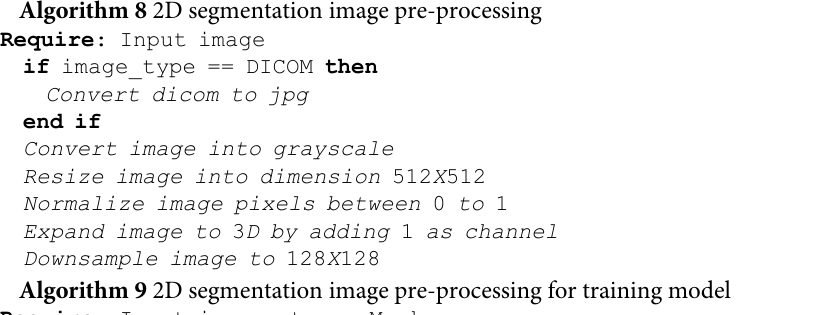
Algorithm 8 2D segmentation image pre-processing